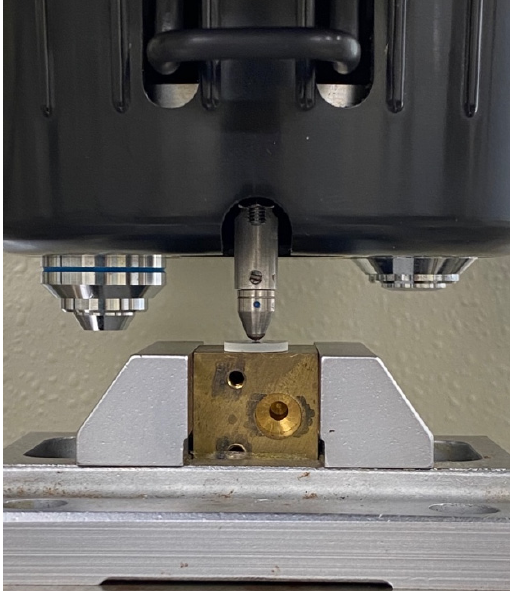
Figure 7. Vickers hardness test setup.